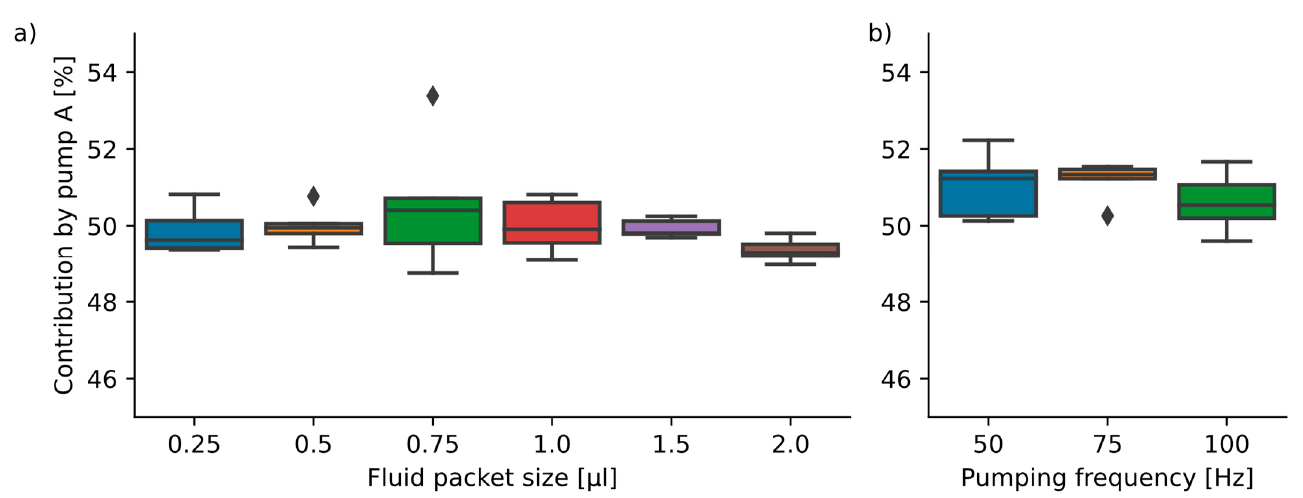
Figure 6. ( a ) Variation in packet size ( n = 6 ∗ 5) at a 100 Hz actuation frequency. The mean and standard deviations are: 0.25 µL: 49.9 ± 0.6%; 0.50 µL: 50.0 ± 0.5%; 0.75 µL: 50.6 ± 1.8%; 1.00 µL: